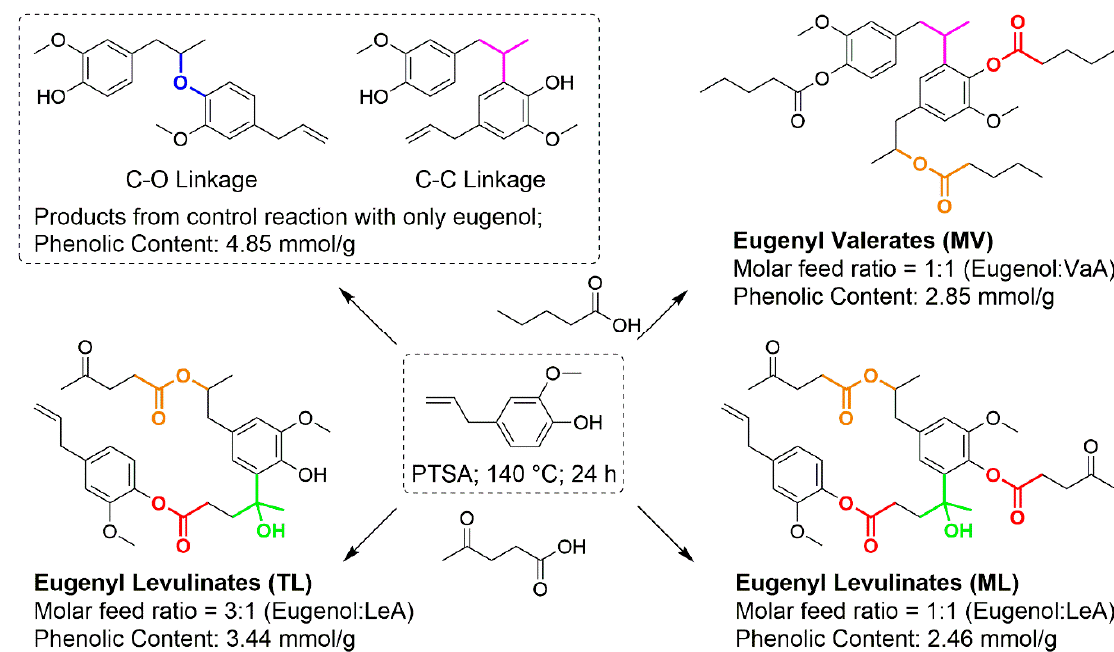
Figure 1. Schematic presentation of the synthesis, representative chemical bonds in the products, from a control reaction with eugenol only and the plasticizer candidates including eugenyl levulinates (ML and TL) and eugenyl valerate (MV) (C-O linkages in blue; C-C linkages in purple; phenolic ester bonds in red; aliphatic ester bonds in orange; converted-ketones in green).